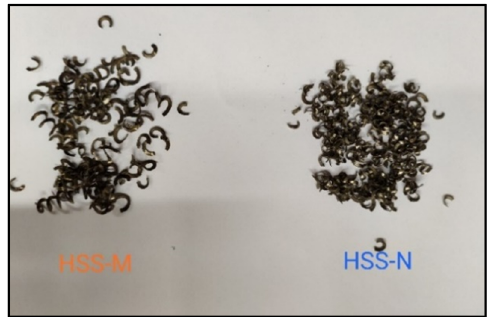
Figure 10: Chip forms obtained during cutting with magnet and non - magnetic